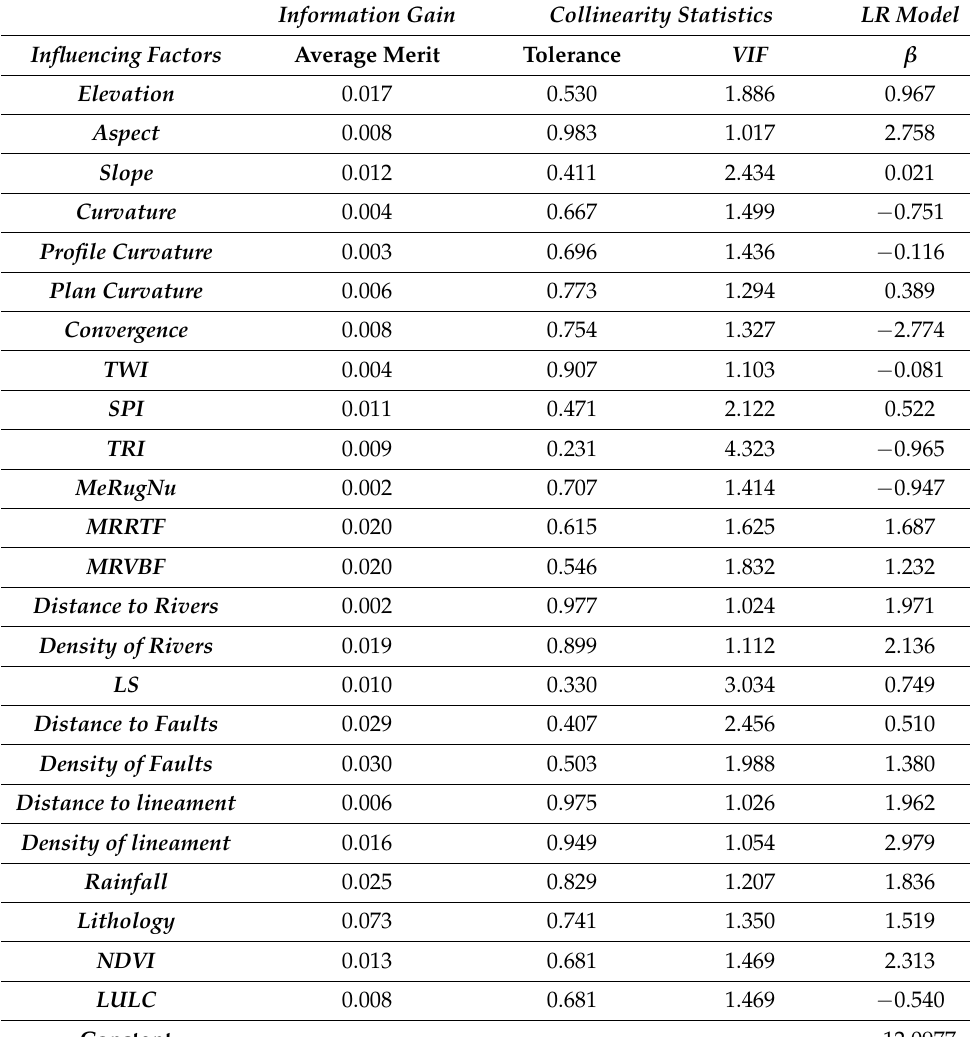
Table 2. Multicollinearity diagnosis, average information gain and parametric statistics (LR model) for the groundwater influencing